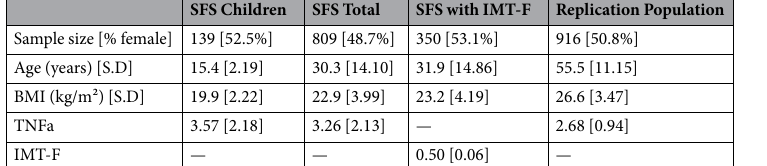
Table 3. Demographic and clinical characteristics of studied